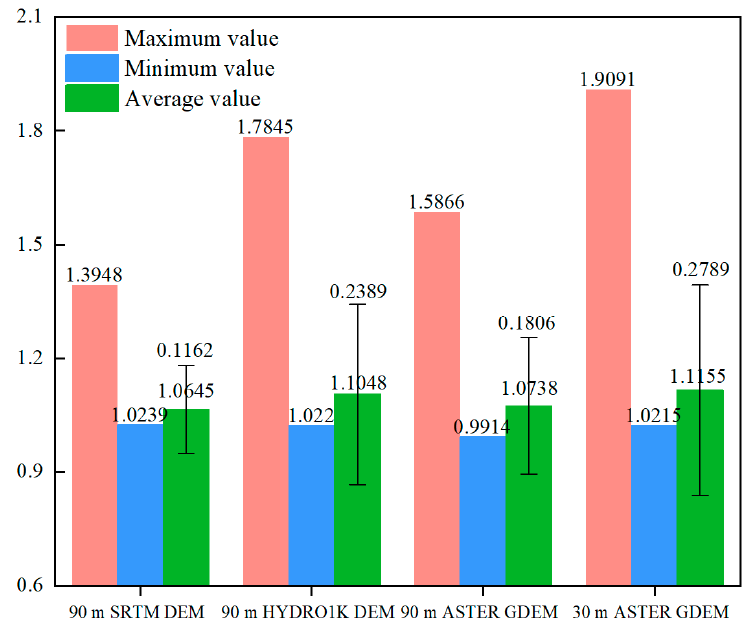
Figure 5. Statistical eigenvalues of fractal dimensions of the four DEM data.